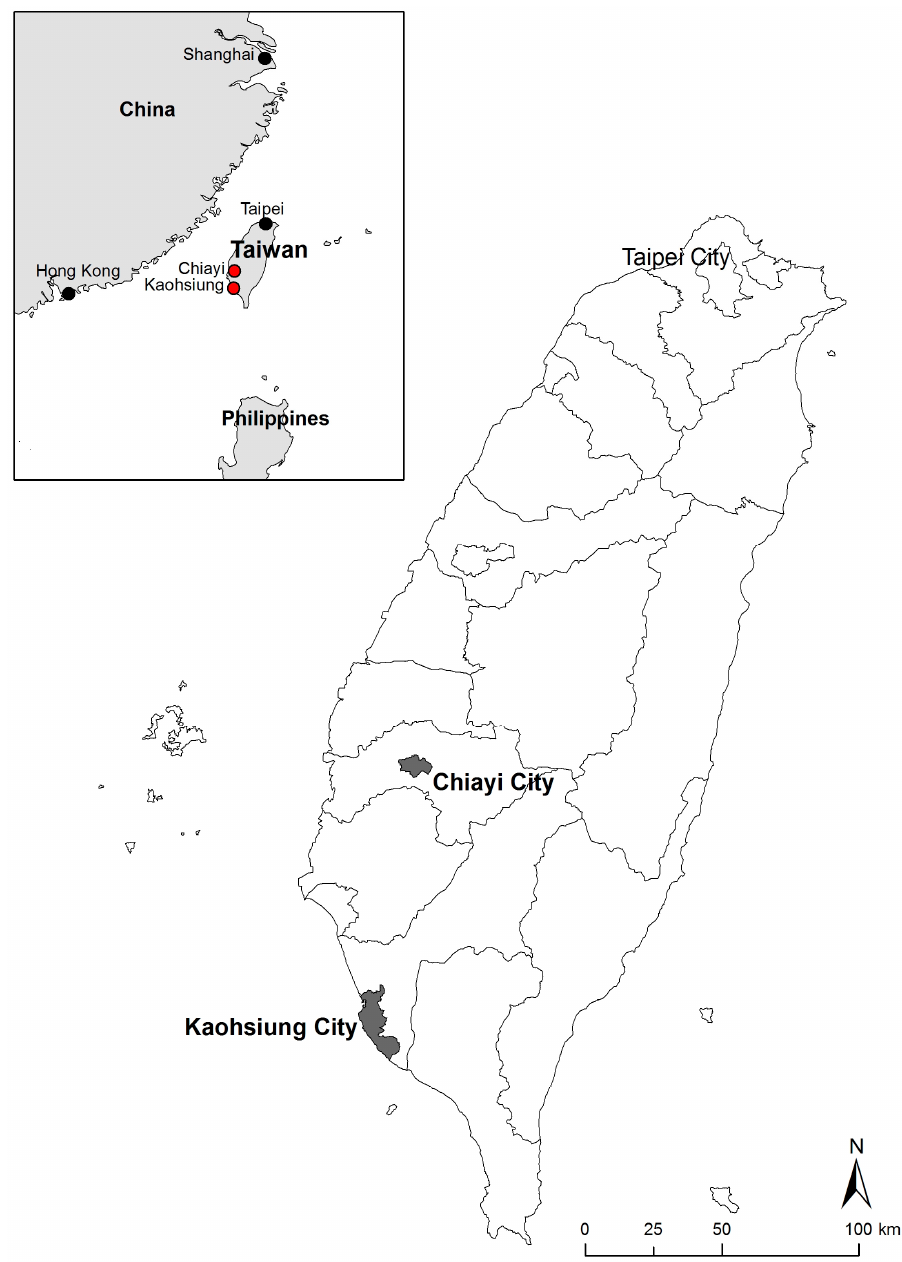
Figure 1. Location of the two study sites (Chiayi City and Kaohsiung City) in Taiwan.